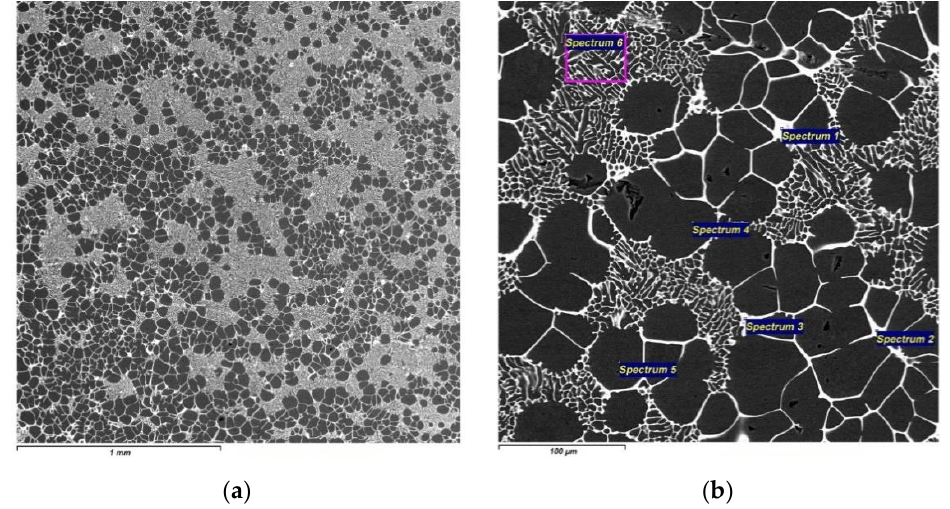
Figure 5. The electronic pictures of the microstructure and the EDX results of master alloys Al-4.2Er cast with a high cooling rate: ( a ) × 40; ( b ) ×